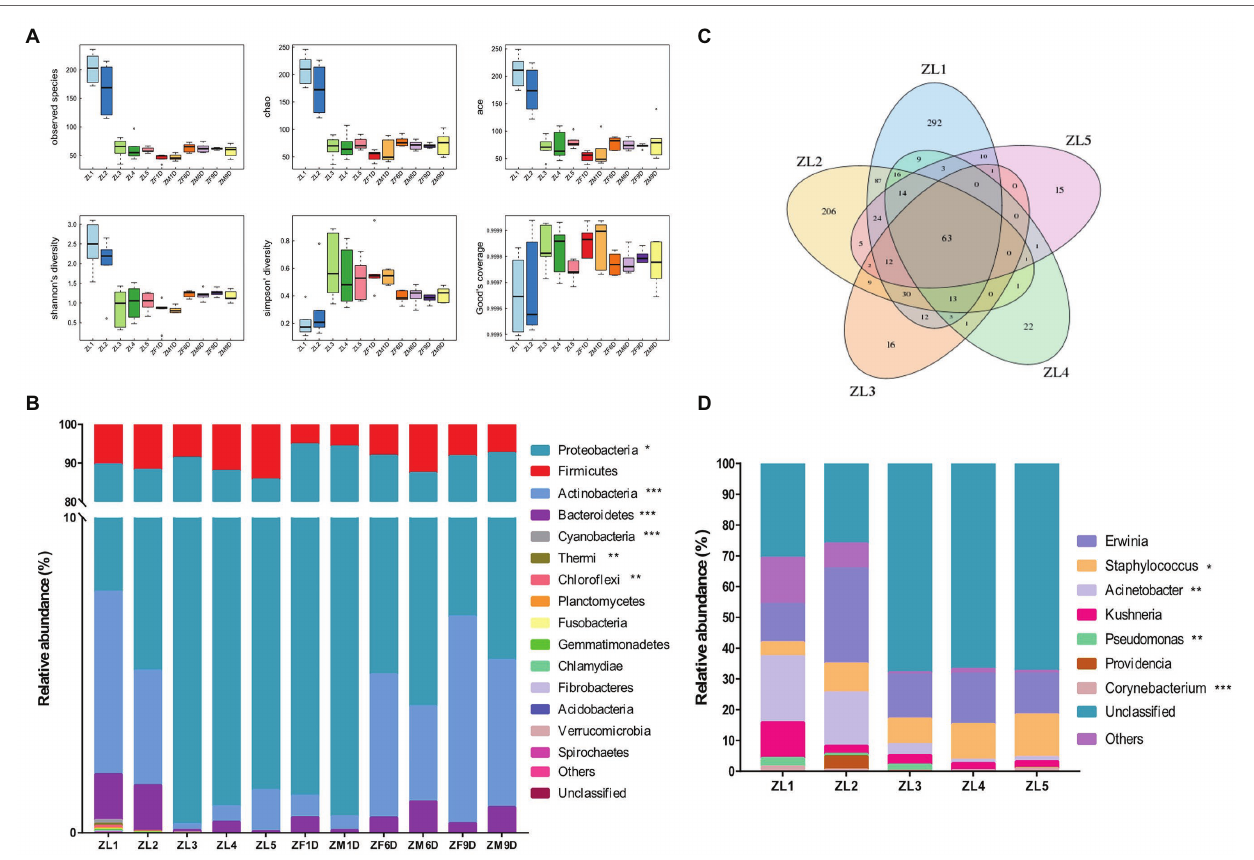
FIGURE 1 | Bacterial community dynamics among different developmental stages in Adelphocoris suturalis . (A) Boxplot of α -diversity measured by the six indexs. (B) Relative abundance of bacteria communities at the phylum level in different groups. (C) Venn diagram showing operational taxonomic unit (OTU) classification in nymphal period. (D) Relative abundance of bacteria communities at the genus level in nymph stages. (Bacteria with relative abundance lower than 0.5% in all samples were all merged into others. Kruskal-Wallis test, *0.01 < p ≤ 0.05, **0.001 < p ≤ 0.01, and *** p ≤